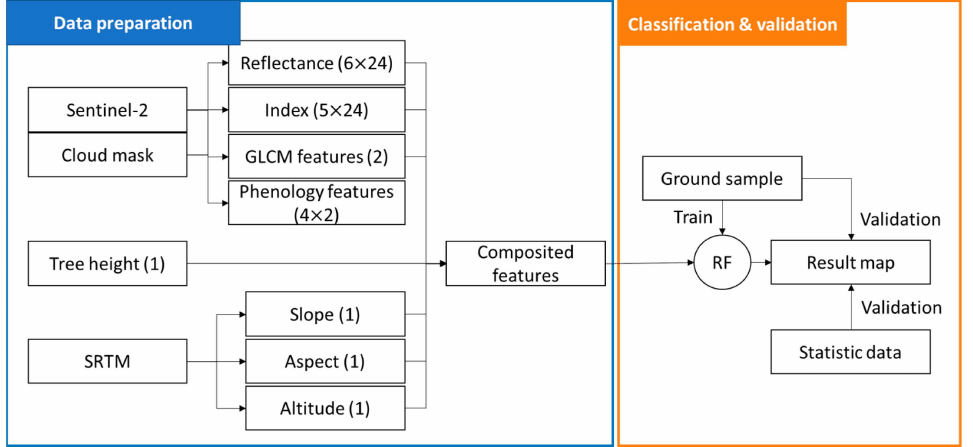
Figure 3. Workflow of this study. Data and features are represented by blocks. RF in the circle represents the random forest classifier. The numbers in the brackets represent the numbers of features and timesteps. Blue and orange colour represents the data preparation and classification-validation steps,